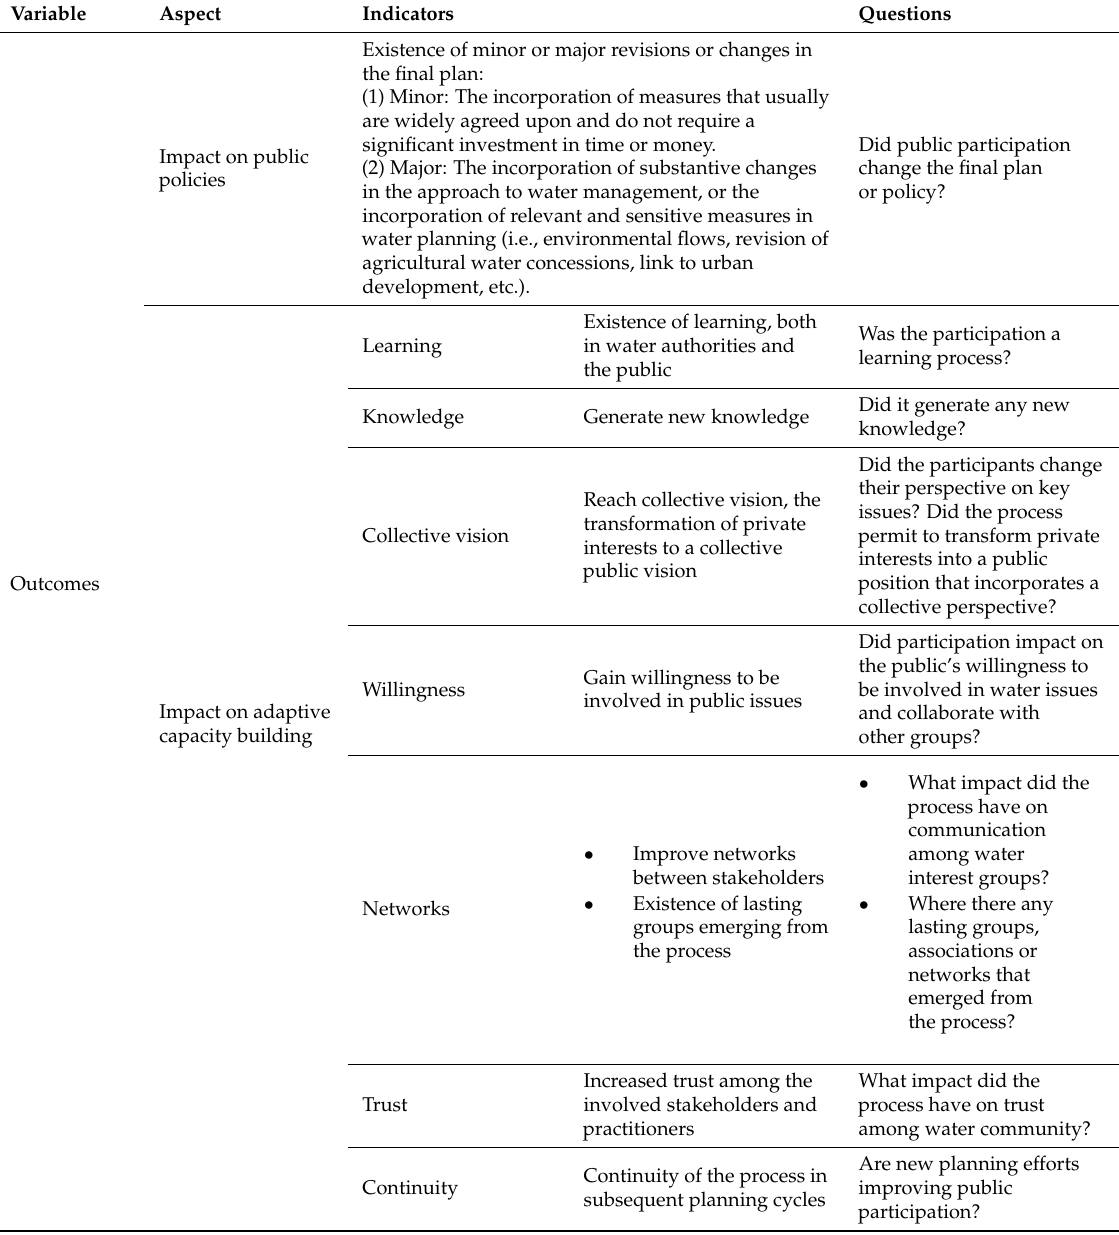
Table 4. Outcomes: Indicators and study questions.